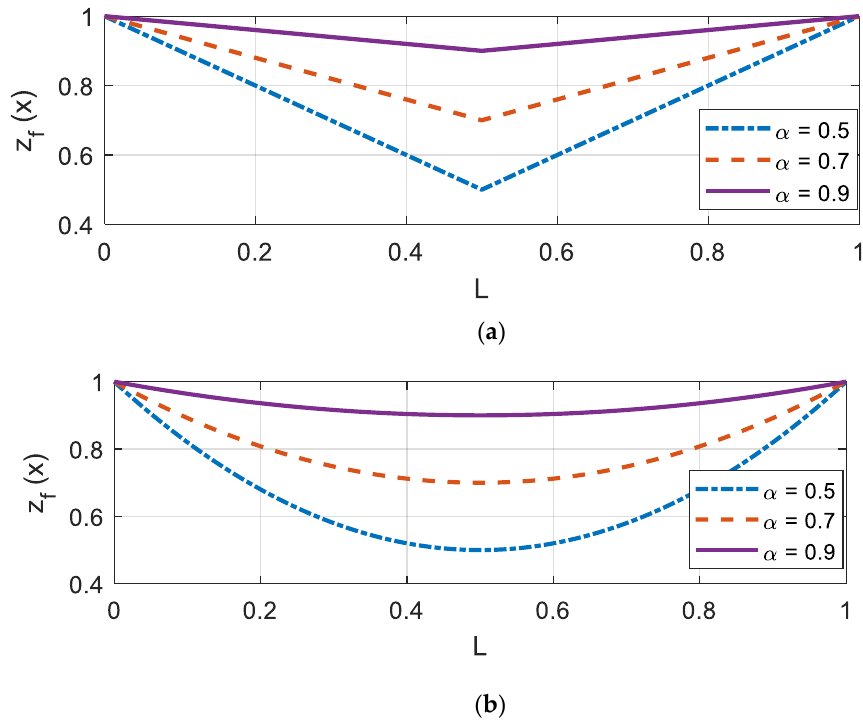
Figure 2. Nonlinear variation in the Winkler foundation ( a ) linear variation; ( b ) quadratic variation.